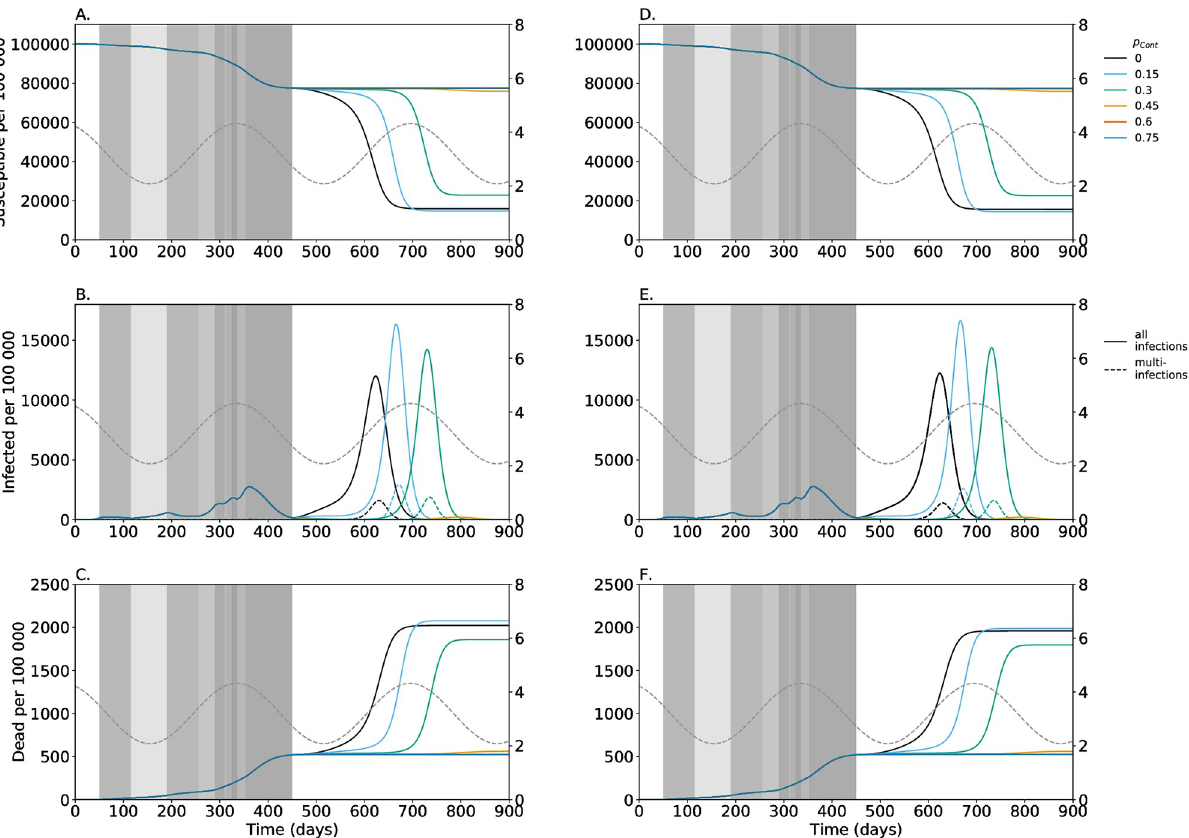
Fig 7. Implication of general distancing after day 450—Considering multiple-infections having an effect or not. As in Fig 2 but colors are for different levels of general contact reduction after day t = 450. Panels A-C assume assume a higher (i) likelihood of symptomatic infections ( ~ f (ii) higher mortality ( ~ f panels D-F neglect these effects ( ~ f